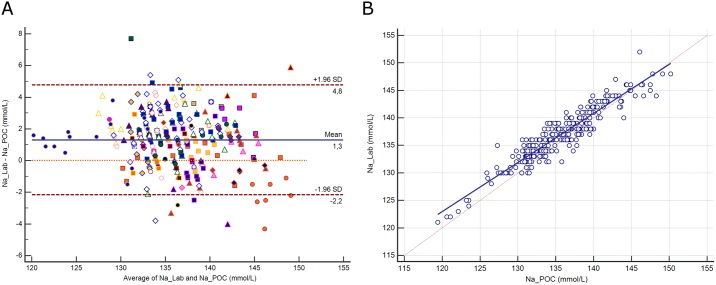
1A. Bland-Altman plot showing the difference versus the average of sodium (Na) measured by the central Lab analyzer and by the POC Siemens RAPIDPoint 500 blood gas system. Bias, upper and lower limits of agreement (±1.96 SD) are represented. The red dotted line indicates equality (difference = 0). There is one marker for each patient. 1B. Scatter diagram showing Deming regression analysis for sodium (Na) measured by the central Lab analyzer and by the POC Siemens RAPIDPoint 500 blood gas system. The regression line (solid line) and the identity line (x = y, dotted line) are represented.